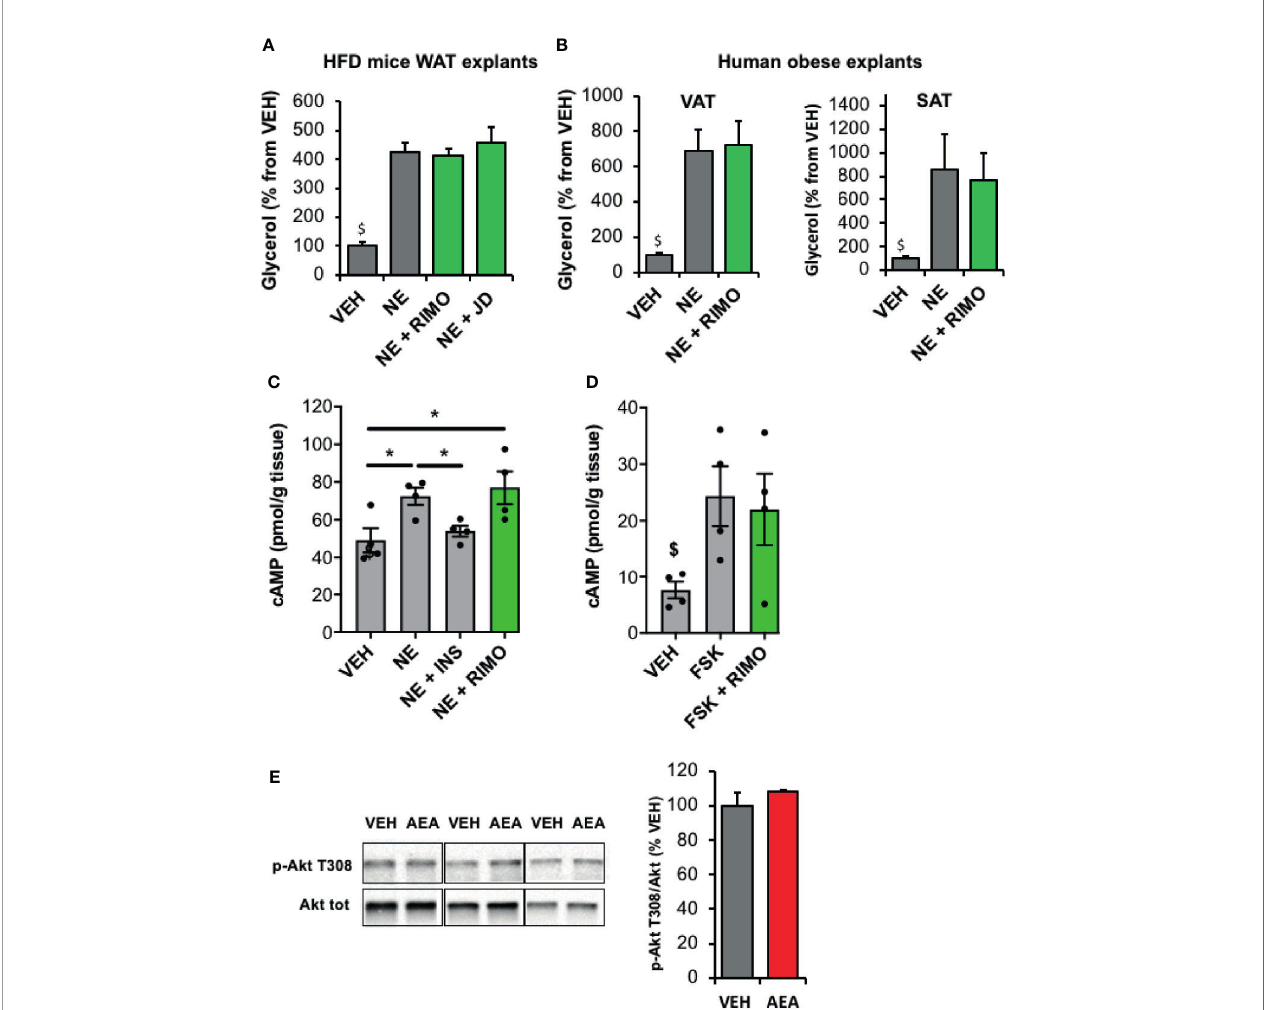
FIGURE 4 | Blockade of WAT CB1R does not modify lipolysis in obese mice and human in vitro . (A) Glycerol production by WAT explants from mice fed with a high fat diet (HFD) and treated 1 hour with vehicle (VEH), Rimonabant (RIMO, 1 µM) or JD5037 (0.3µM) in the presence of norepinephrine (NE, 1 µM). Explants were treated in triplicate and experiments repeated with 3 different HFD mice (n=3/group). $ p < 0.001 VEH vs other treatments. (B) Glycerol production by abdominal VAT or SAT explants from obese subjects measured in the medium after 1-hour treatment with VEH or RIMO (1 µM) in the presence of NE (1 µM). Explants were treated in triplicate and experiments repeated with tissue from 6 different obese subjects (n=6/group). $ p < 0.001 VEH vs other treatments. (C) Intracellular cAMP content measured in WAT explants from HFD mice treated 1 hour with VEH, insulin (INS, 1 nM) or RIMO (1 µM) in the presence of NE (1 µM); n=4/group. (D) Intracellular cAMP content measured in WAT explants from HFD mice treated 15 min with VEH, forskolin (FSK, 10 µM) or FSK + RIMO (1 µM); n=5/group. $ p < 0.001 VEH vs other treatments. (E) Representative immunoblots and densitometry analyses of the phosphorylation level of Akt (T308) in WAT explants collected from HFD mice and treated 20 min with VEH or AEA (5 µM); n=3/group. Results are expressed as mean ± SEM. *p <